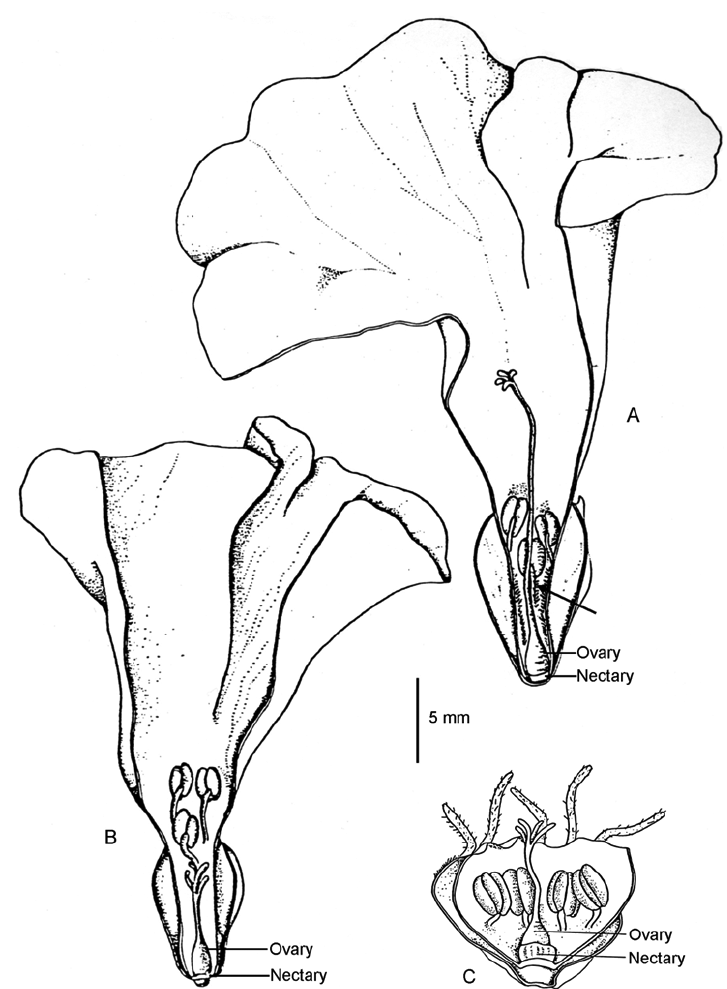
Fig. 1 – Schematic longitudinal sections showing the reproductive structures and the nectary of longistylous (A) and brevistylous (B) flowers of Cordia leucocephala (arrow points to trichomes), and longistylous flowers of C. globosa (C). An Acad Bras Cienc (2010) 82